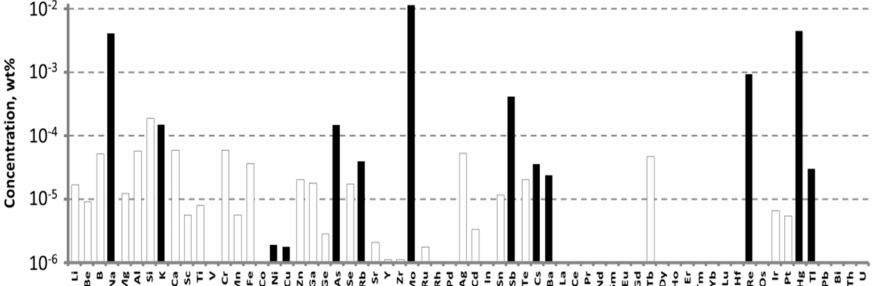
Figure 2. The impurity composition of the WO 3 5N from “LANHIT, Ltd.” measured by